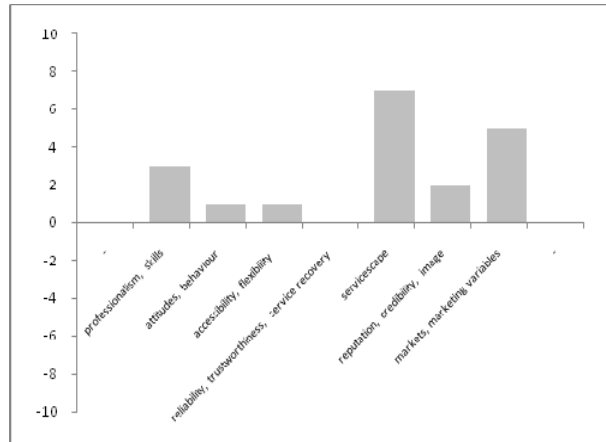
Figure 6: The underlying drivers of consumption in Factor 3